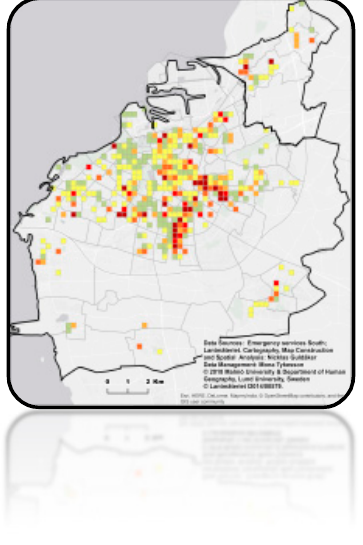
Figure 9. Choropleth map—Subarea. Figure 10. Choropleth map - grids.